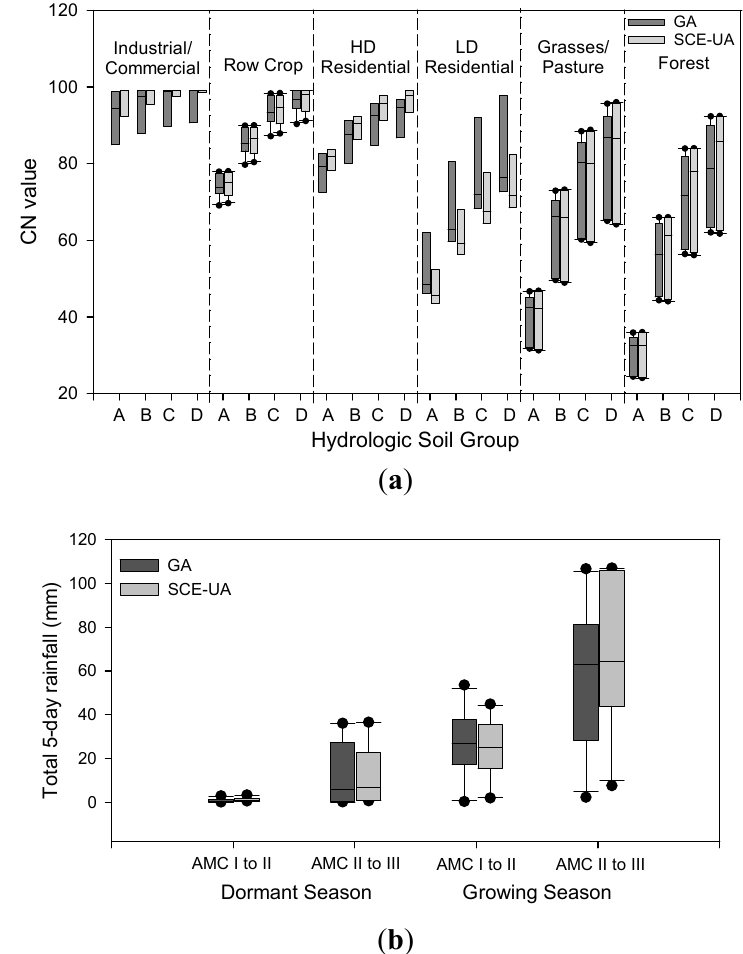
Figure 13. Comparison of box plots of CN values ( a ) and total 5-day rainfall ( b